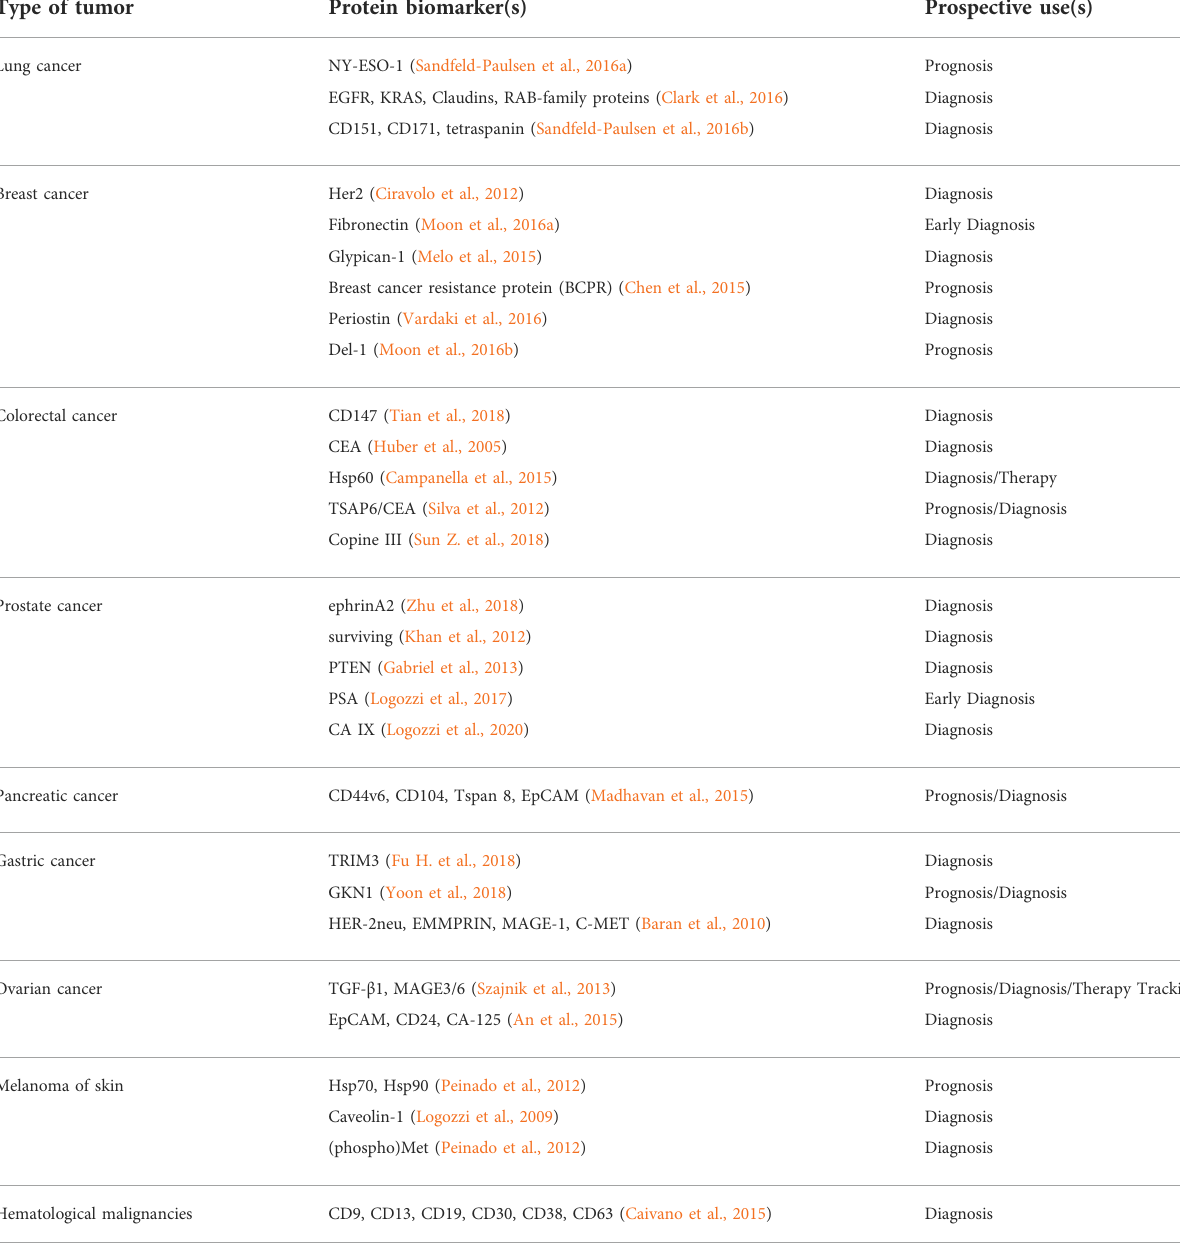
TABLE 1 Exosomal proteins as biomarkers for diagnosing cancer from serum and